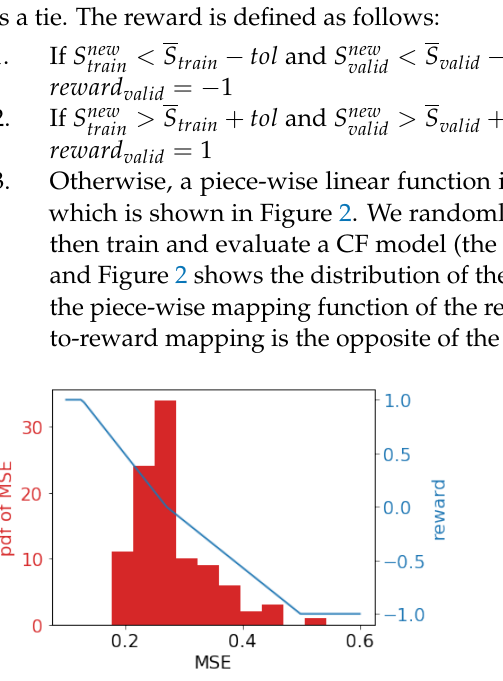
Figure 2. Score-reward mapping function of the